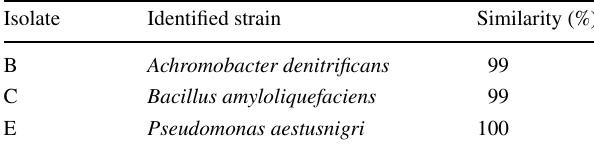
Table 2 molecular identification of the obtained